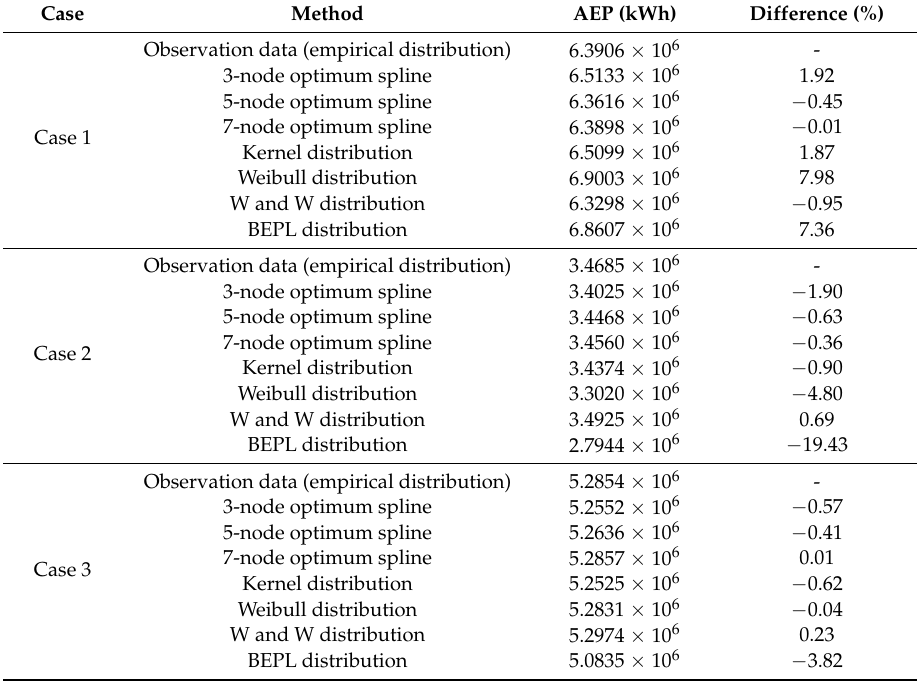
Table 4. Comparison of annual energy production calculations based on different distribution